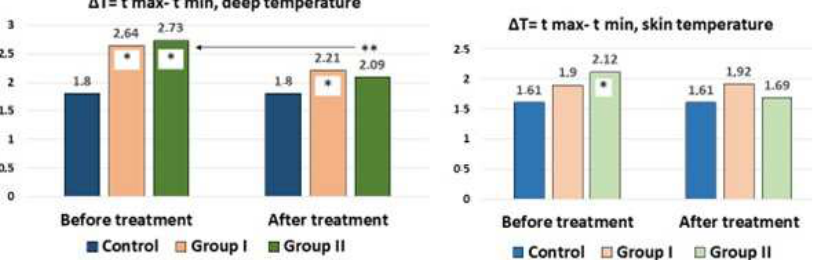
Figure 4. Temperature gradients of internal and skin temperatures in the lumbar region during traditional treatment (Group I) and for combination treatment with the inclusion of percutaneous neurostimulation (Group II) in comparison with the control group. * Statistically significant difference in relation to control; ** in relation to their group before treatment at p < 0.05 (assessment by the Mann–Whitney test).